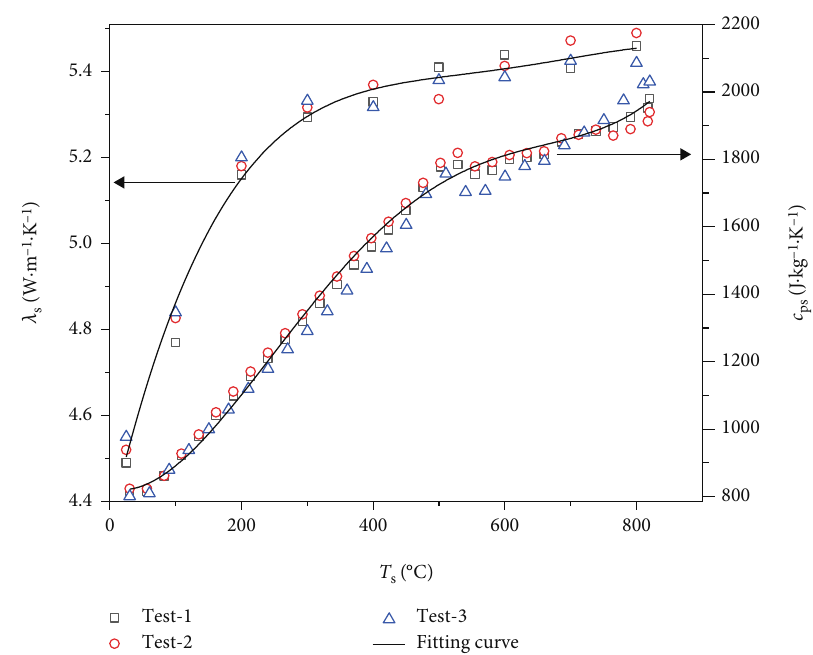
Figure 3: Measured data of the thermal conductivity λ